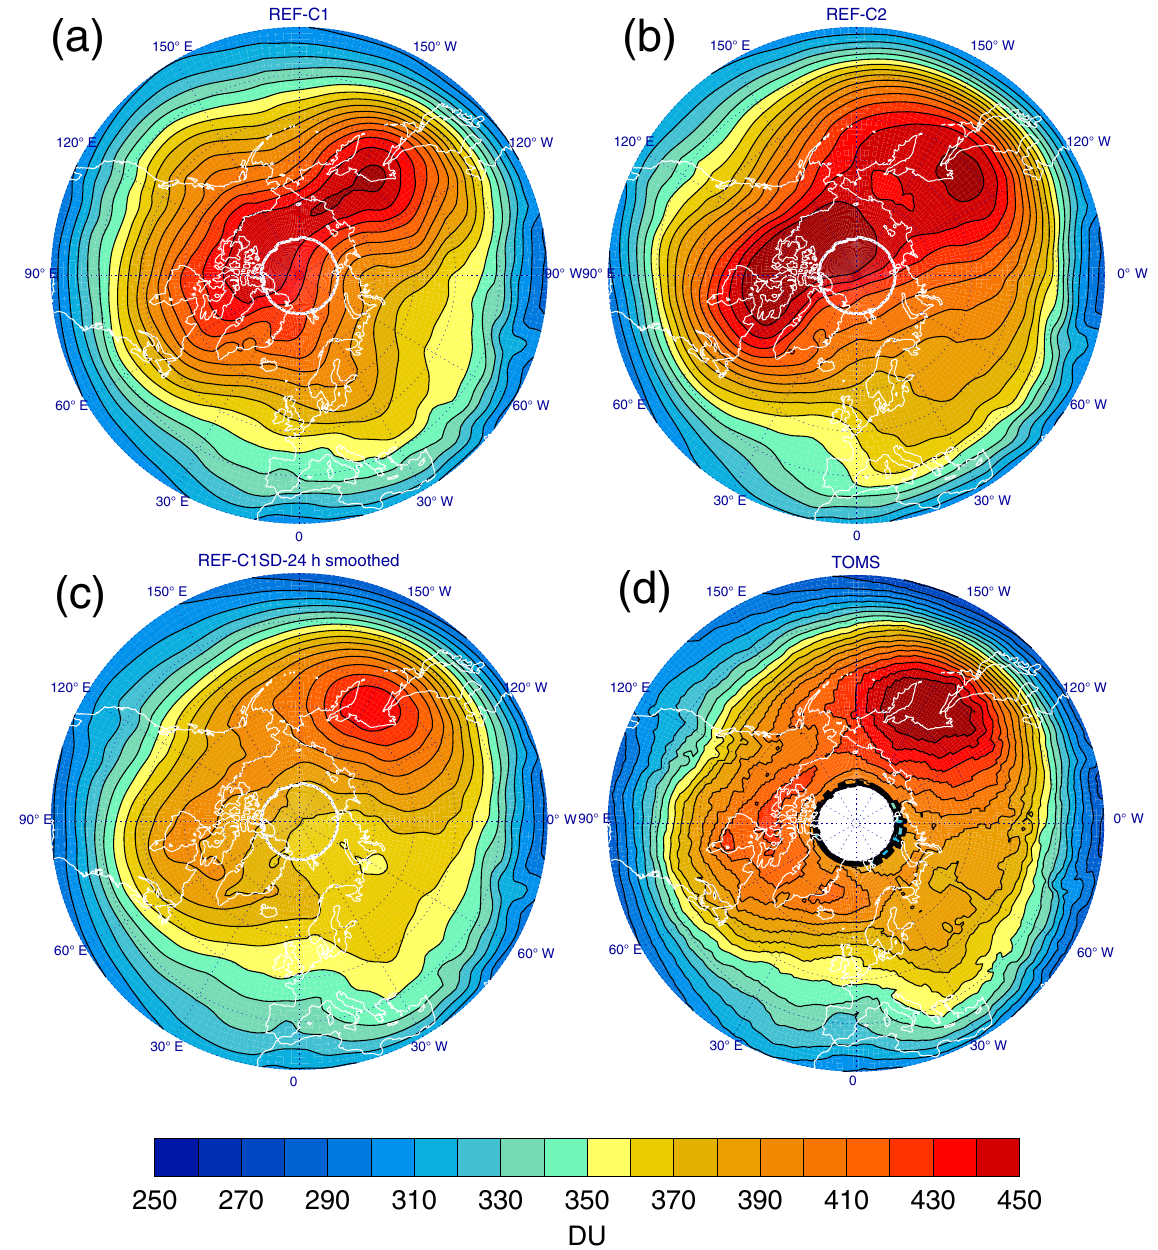
Figure 15. The same as in Fig. 14, but for climatological TCO in Northern Hemisphere